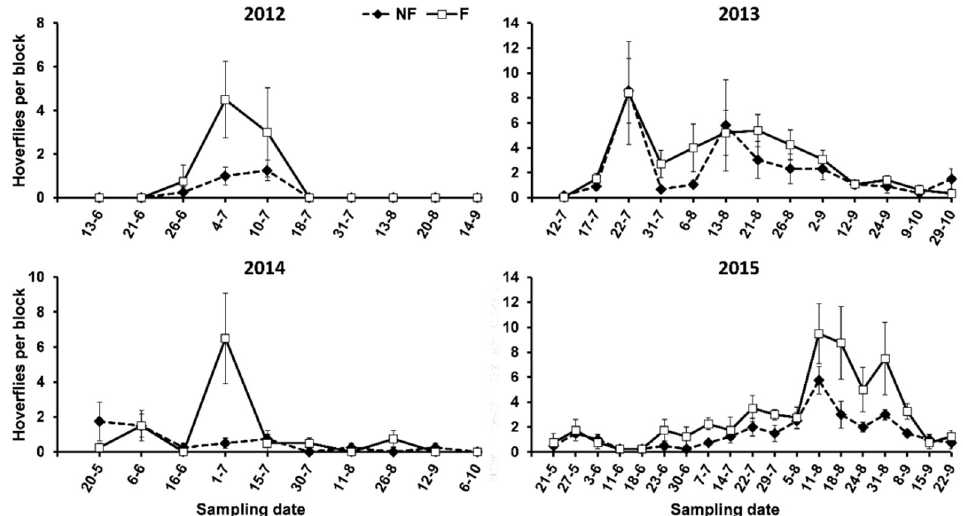
Figure 2. Abundance of hoverflies on oleanders surrounded (F) and not surrounded (NF) by service plants in the study period.